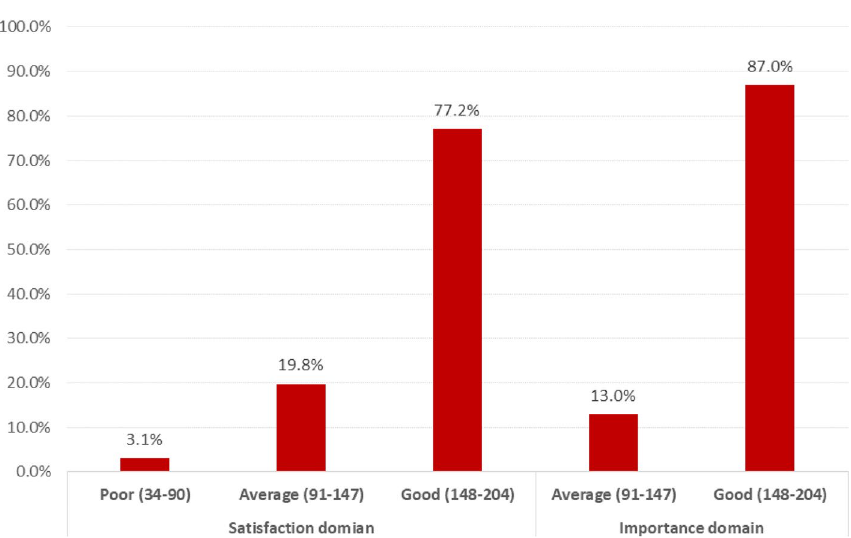
Fig. 1 QOL for patients on HD, Aseer region, Saudi Arabia